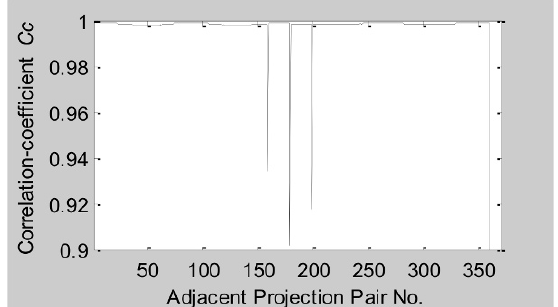
Figure 8. Correlation-coefficient for motion free ideal case.